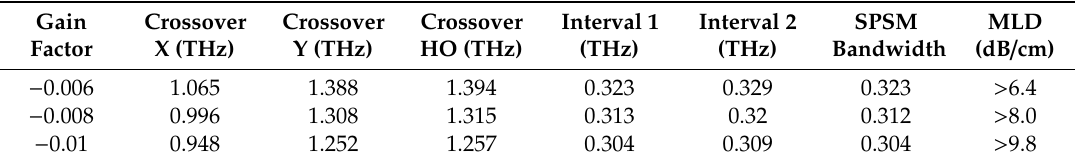
Table 1. Crossover points, interval size, SPSM bandwidth, and minimum loss di ff erence (MLD) values for di ff erent gain factors, ξ .